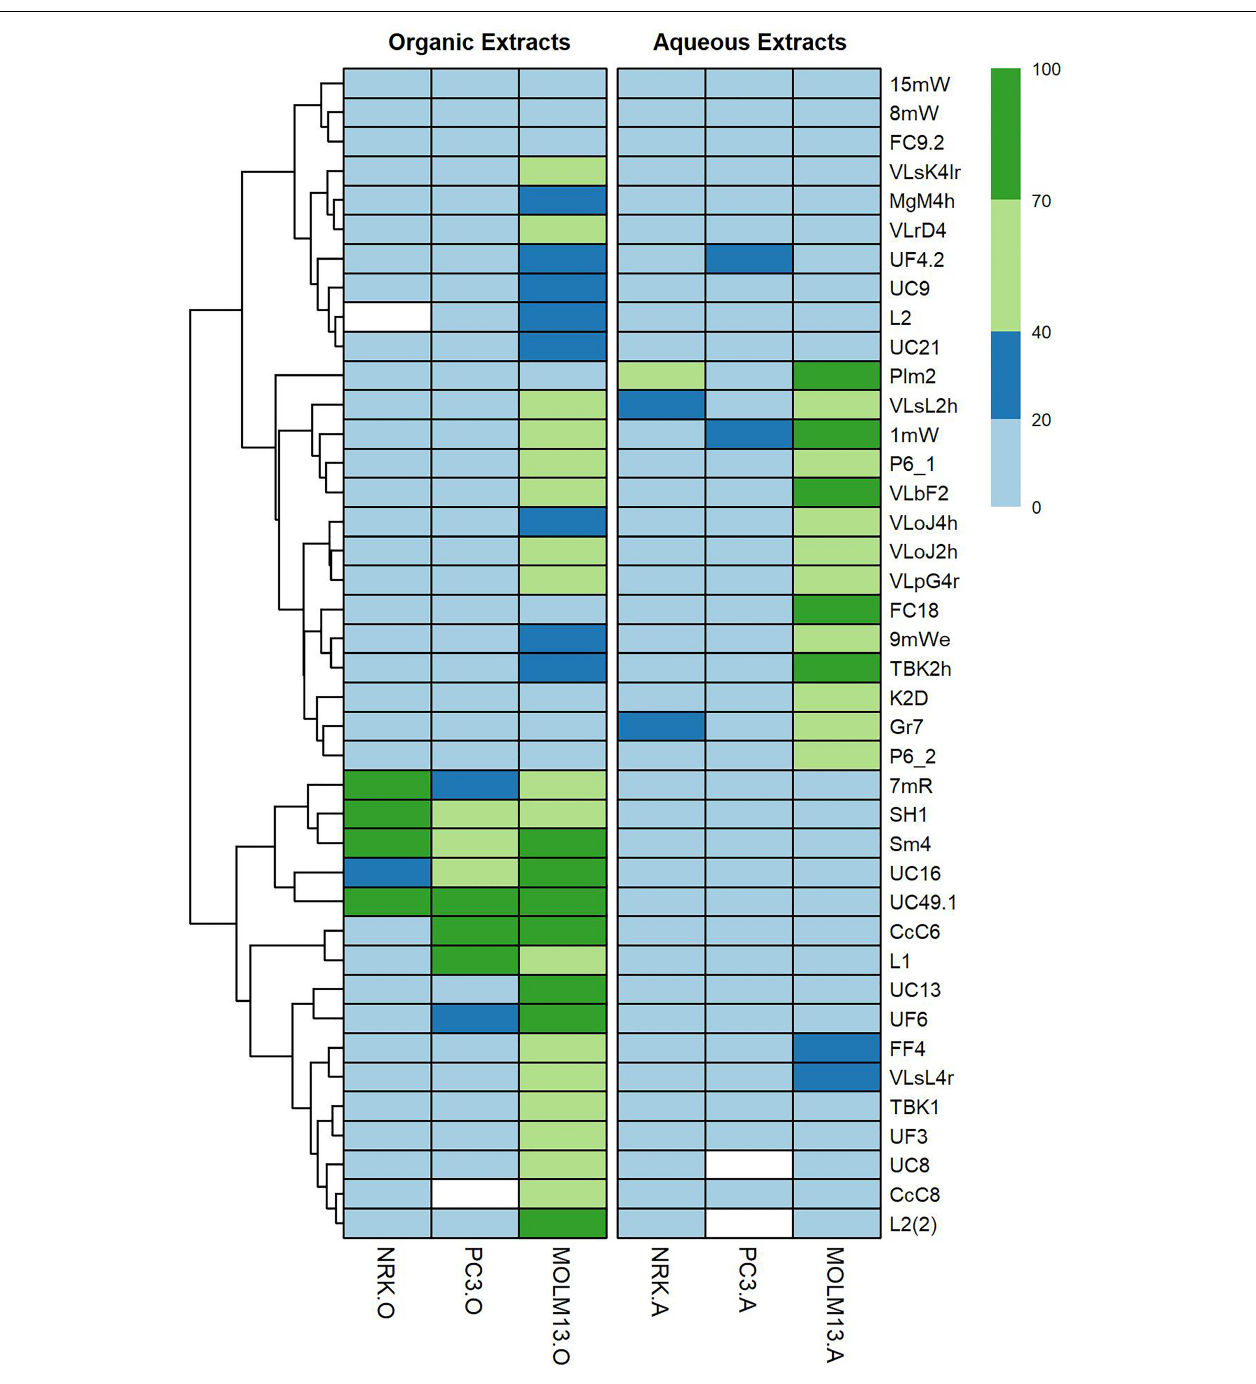
FIGURE 1 | Heat-map showing the different degrees of toxicity that organic and aqueous extracts of Planctomycetes induced in NRK, MOLM-13 and PC3 cell lines. From strain L2, extracts were obtained after 7 and 15 days of cultivation [L2 and L2(2), respectively]. Heat-map scale: 0–20% – no toxicity; 20–40% – low toxicity; 40–70% – intermediate toxicity; 70–100% – high toxicity. White boxes – Not evaluated. Graph was created in R studio program, using pheatmap package. Cluster analysis was based on Euclidean Distance.